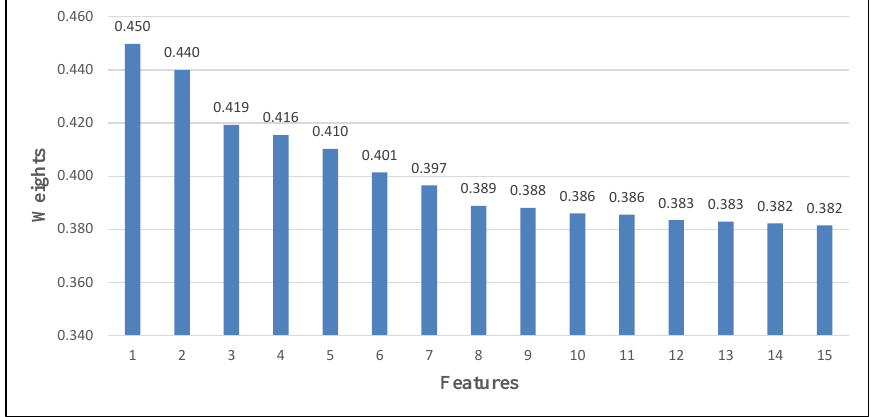
Figure 6. WOA-SVM weights for the features of Data 4.